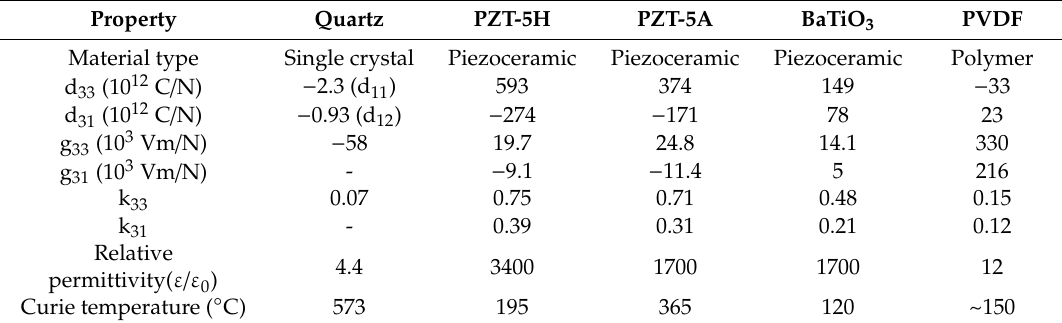
Table 4. Characteristic coe ffi cients of typical piezoelectric